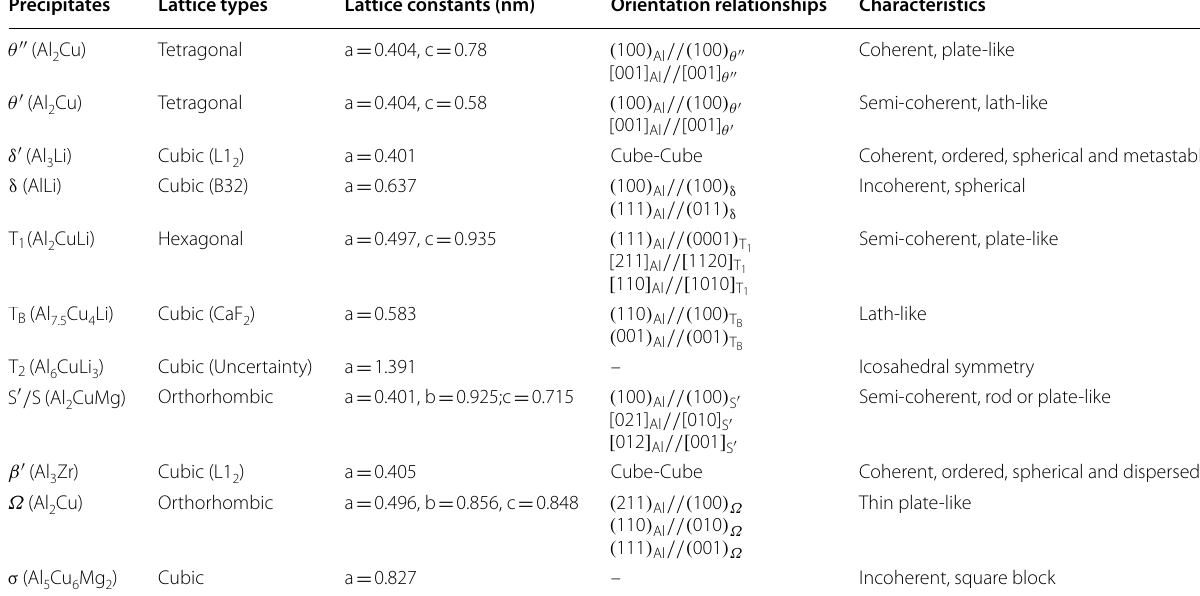
Table 3 Common precipitates in Al–Li alloys and their crystal structure information [3, 102, 103]